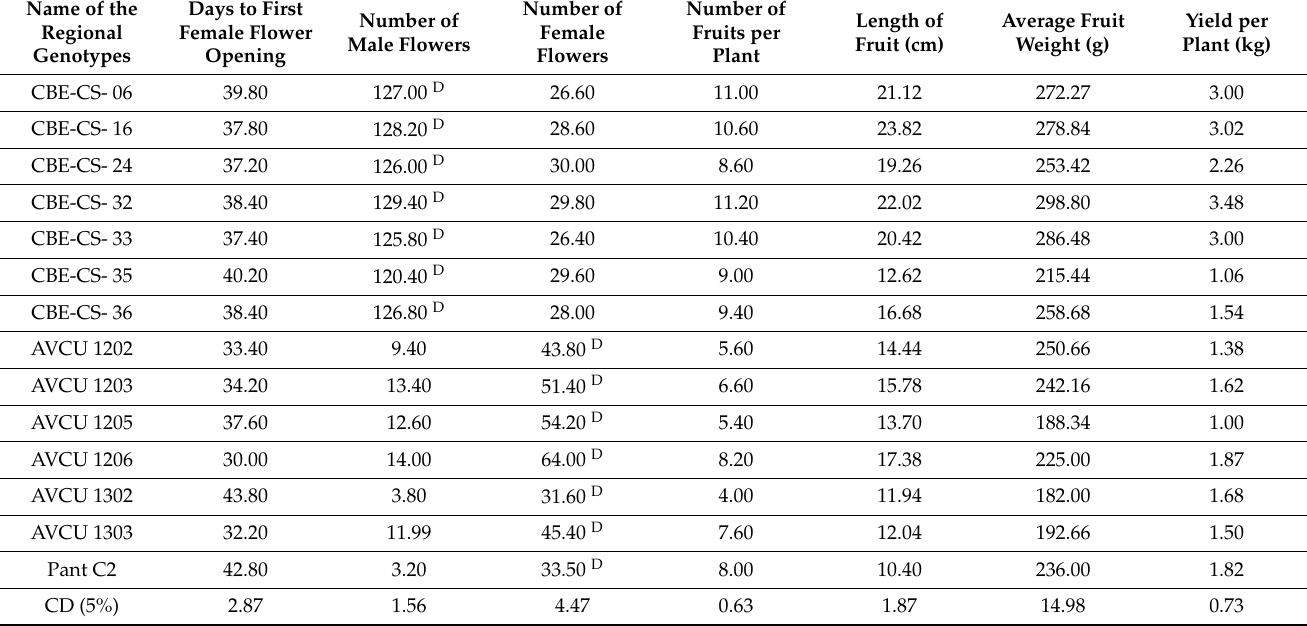
Table 1. Growth and yield performance of investigated cucumber lines with three